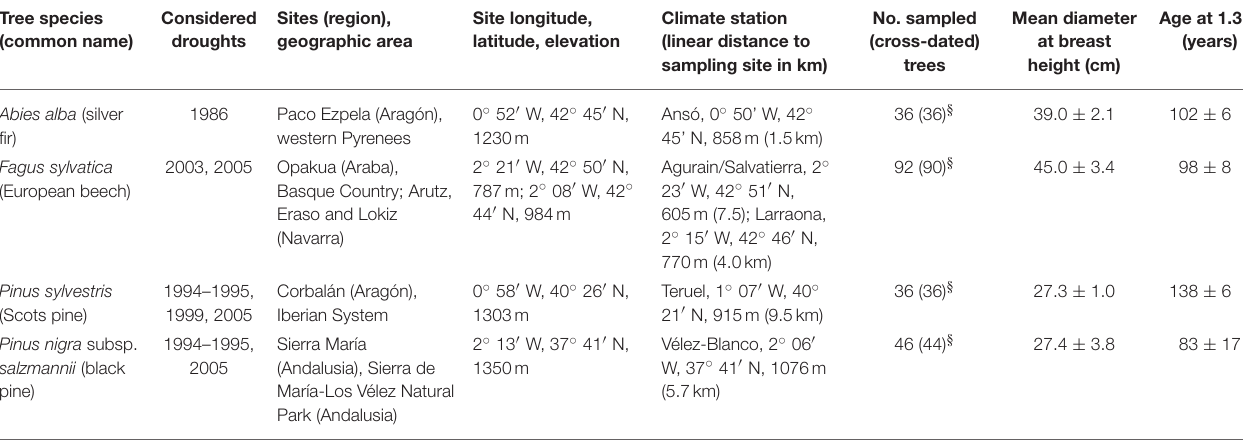
TABLE 1 | Characteristics of the study forests used to quantify tree growth responses to drought across different Spanish regions. Tree species (common